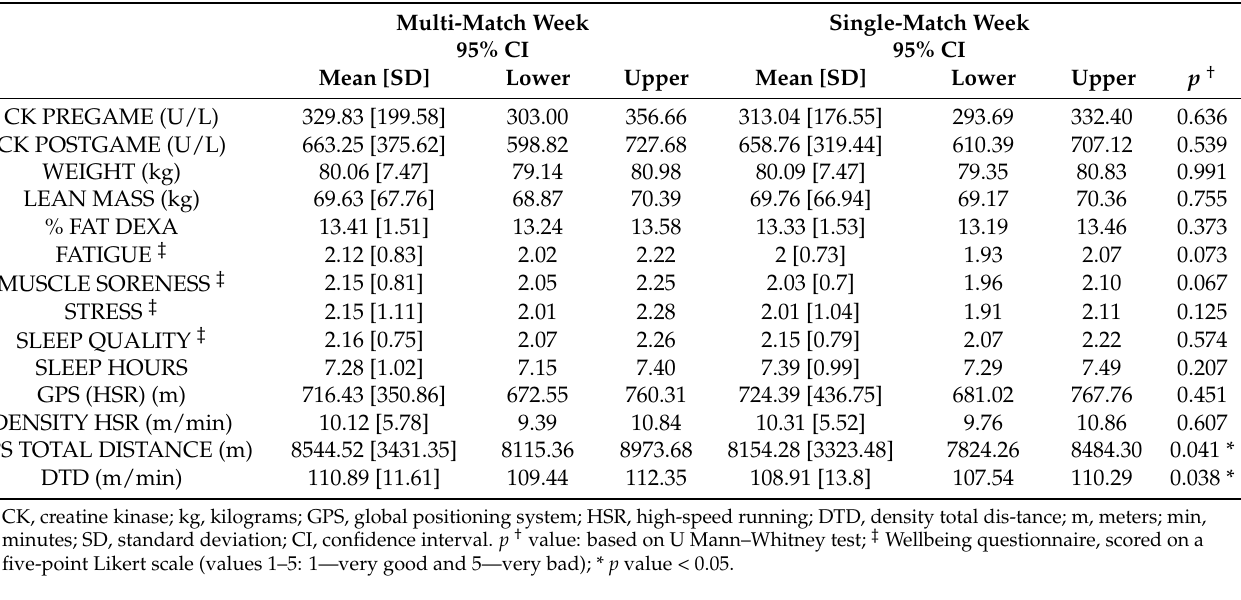
Table 1. Comparative assessment of muscle damage, wellbeing, body composition and match performance data in multi-match vs. single-match weeks in professional soccer players playing in the English Premier League.